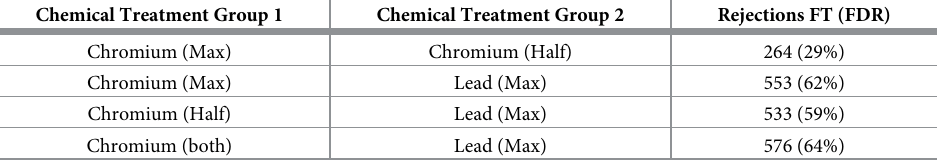
Table 6. Variability within and between treatments: Results of the LSW–FT (FDR) analysis reported in Section 3.4.1.